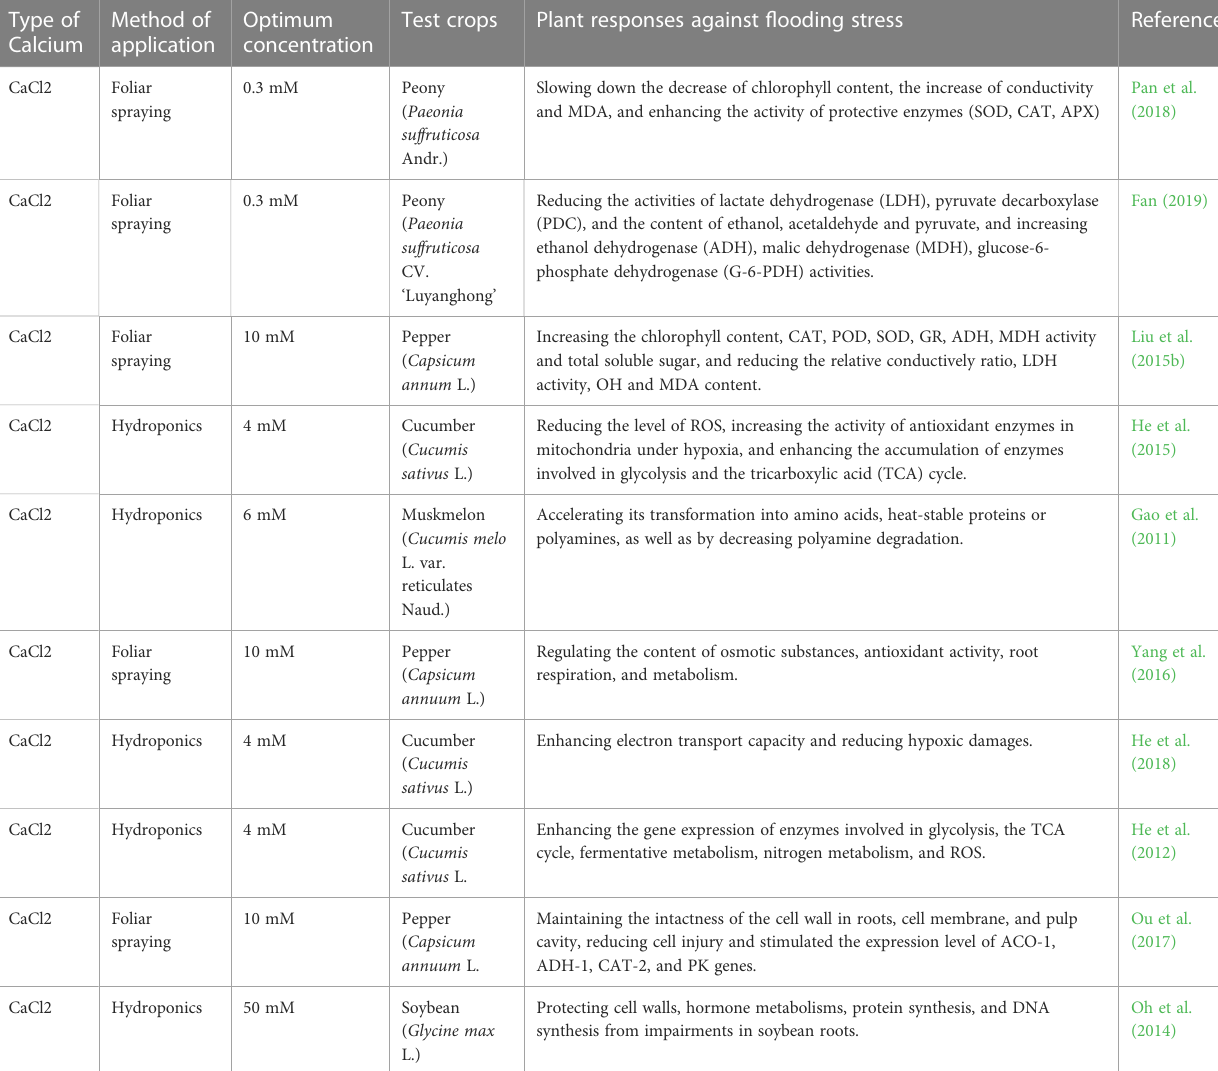
TABLE 2 List of optimal concentrations of exogenous calcium used to alleviate fl ooding stress on different